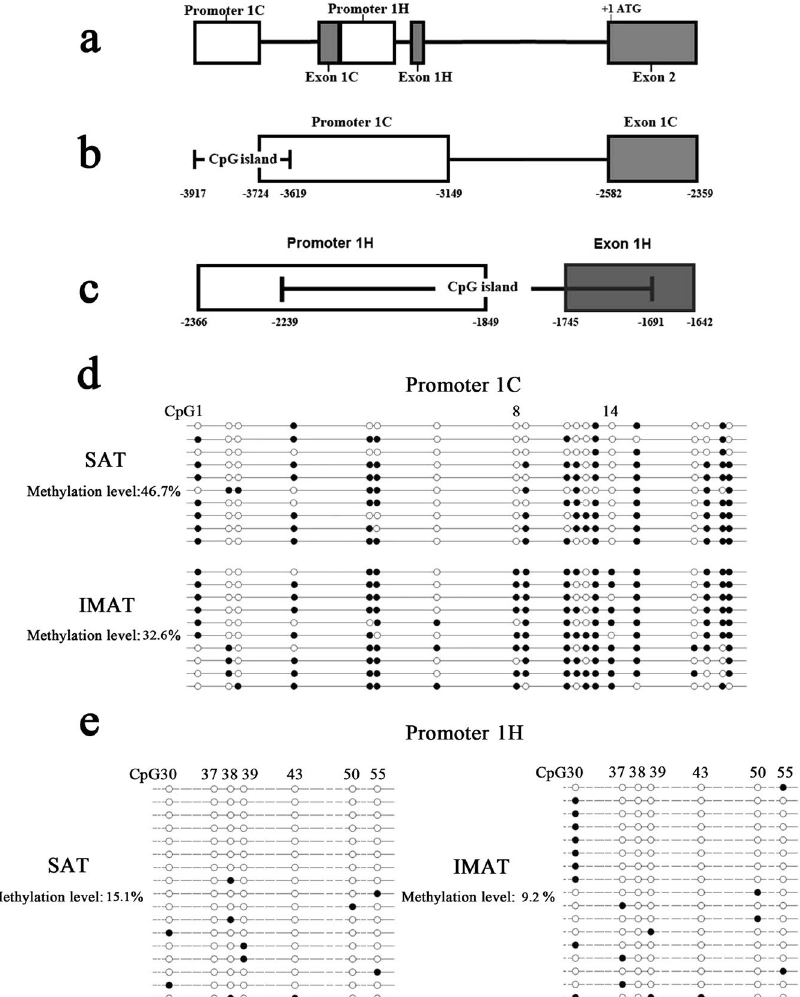
Figure 7. Methylation levels of promoter 1-C and 1-H were higher in IMA. ( a ) Locations of promoter 1-C and 1-H. The gray vertical bars represent the exons of GR gene; the open bar represents the promoter. ( b ) Location of CpG island in promoter 1-C. ( c ) Location of CpG islands in promoter 1-H. Nucleotide numbering is relative to + 1 at the initiating ATG codon. ( d ) Methylation status of promoter 1-C in IMA and SA. ( e ) Methylation status of promoter 1-H in IMA and SA. Each line represents an individual bacterial clone that was sequenced. Open circles indicate unmethylated CpG sites. Black circles indicate methylated CpG